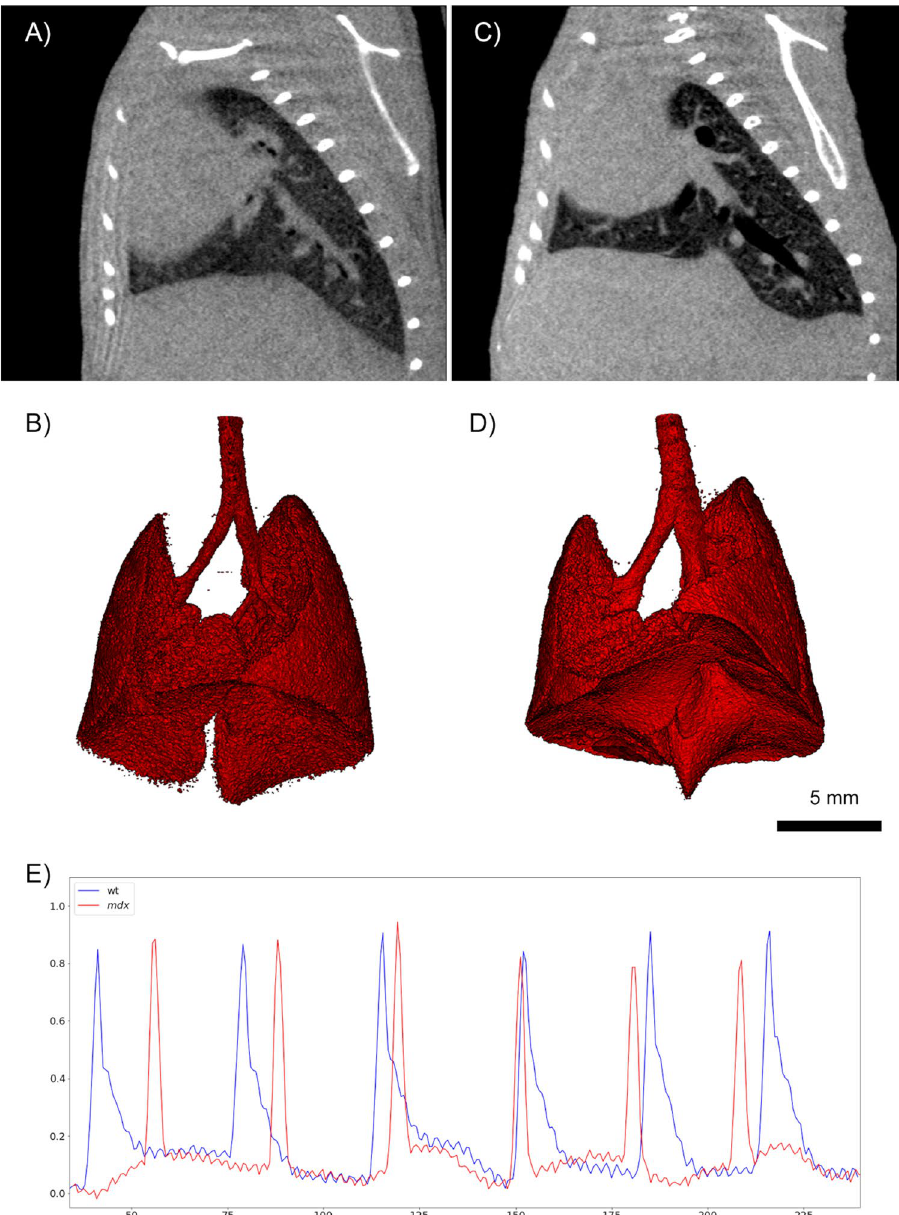
Figure 4. Cross sections of ( A ) a CT image of a healthy control in comparison to ( C ) of a mdx mouse show a modified shape and an altered position of the diaphragm in the mdx mouse. The same deformation of the lung can be observed in the 3D renderings of the segmented lung of the healthy mouse ( B ) and the mdx mouse ( D ), especially for the post-caval lobe (§). ( E ) shows the extracted breathing pattern for the same mice (healthy = blue and mdx = red). Clearly the mdx mouse displays a more rapid decay in the expiration phase. The figure was generated using imagej 1.53f www. imagej. nih. gov/ ij/, using matplotlib 3.5.1 www. matpl otlib. org, gimp 2.10.28 www. gimp. org and scry (proprietary 3D render software)